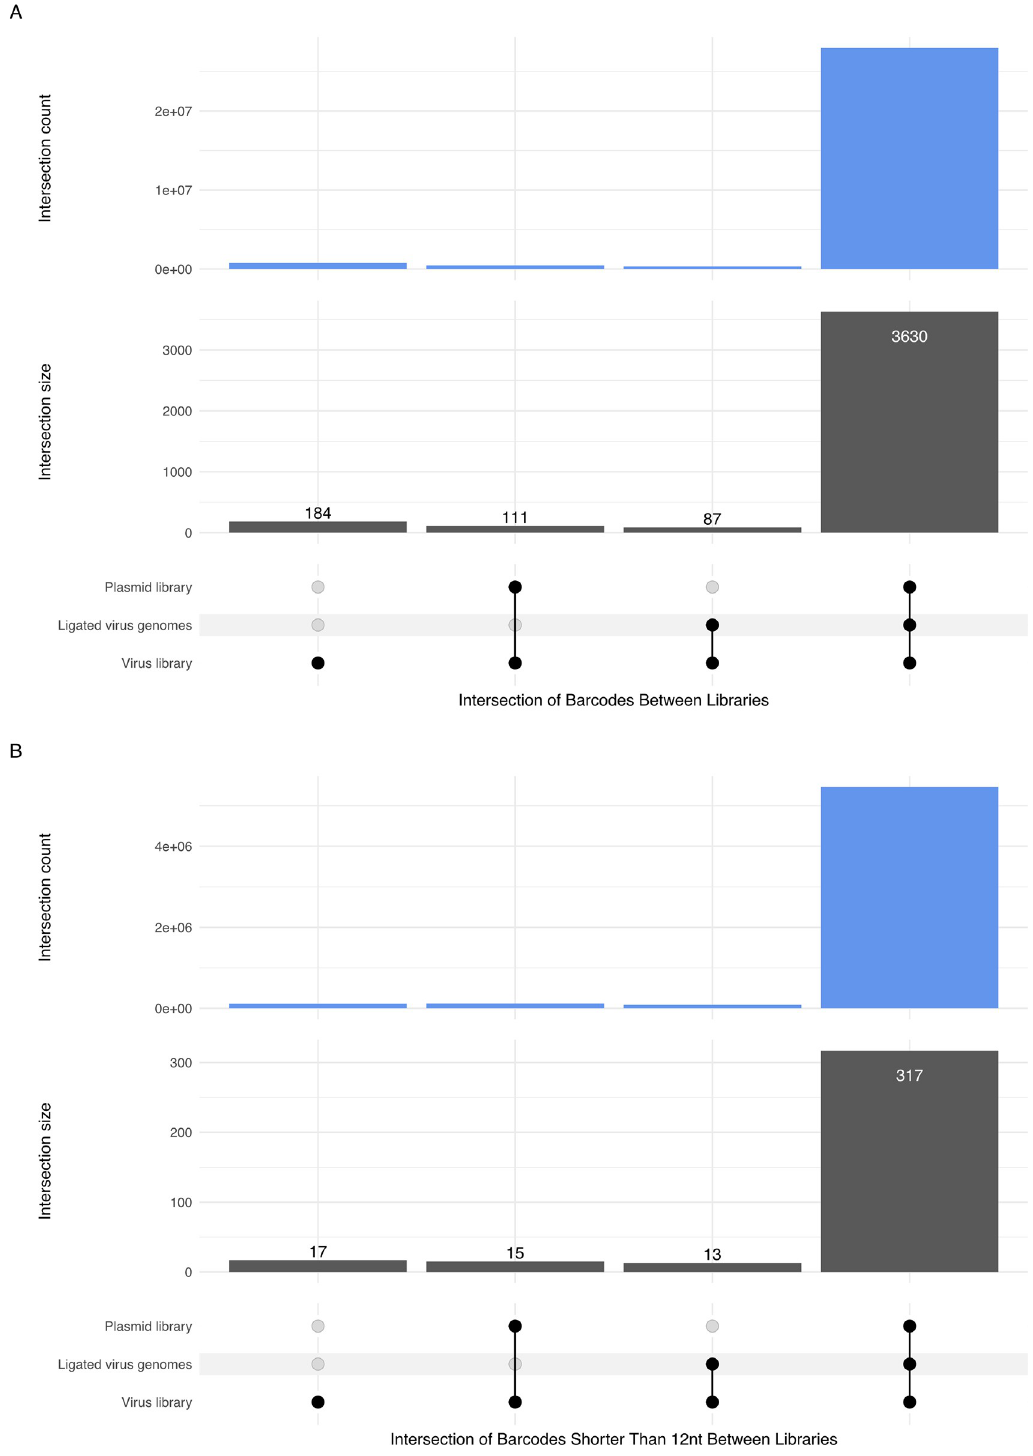
Fig 10. Overlap of clustered barcodes from the plasmid library, ligated virus genomes, and the virus library. A. L3 clustering distance of barcodes along with a 99% cumulative count cutoff was applied to the three libraries. In the lower panel, the UpSet plot shows the number of barcodes from the virus library that intersect with barcodes from the plasmid library and/or the ligated virus genomes. Data show that the vast majority of barcodes from the virus library are present in the plasmid library and the ligated virus genomes. In the top panel, the UpSet plot represents the total read counts associated with barcodes in the